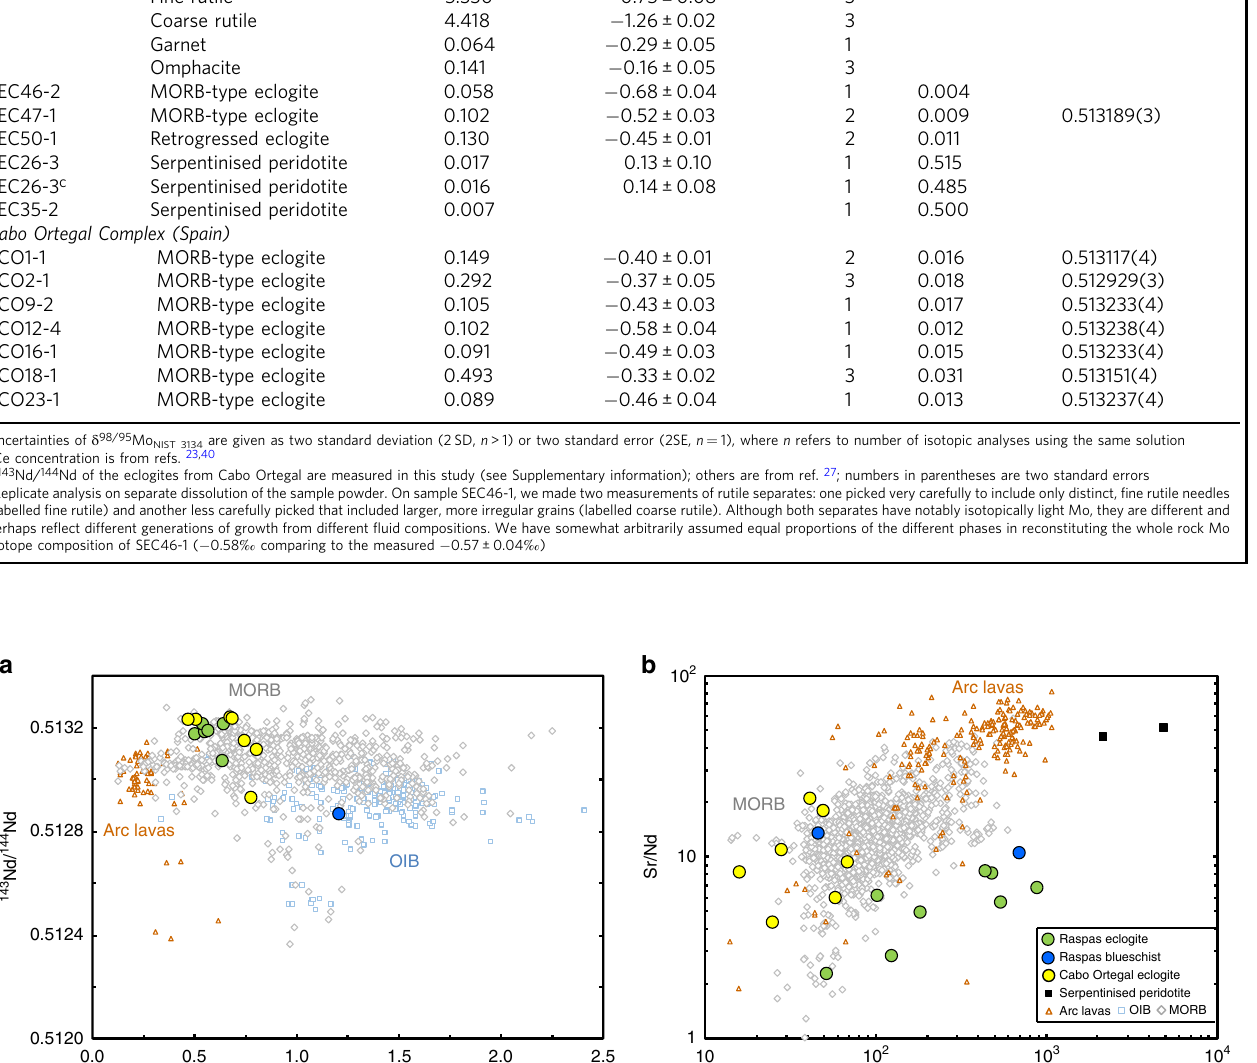
NATURE COMMUNICATIONS| (2019) 10:4773